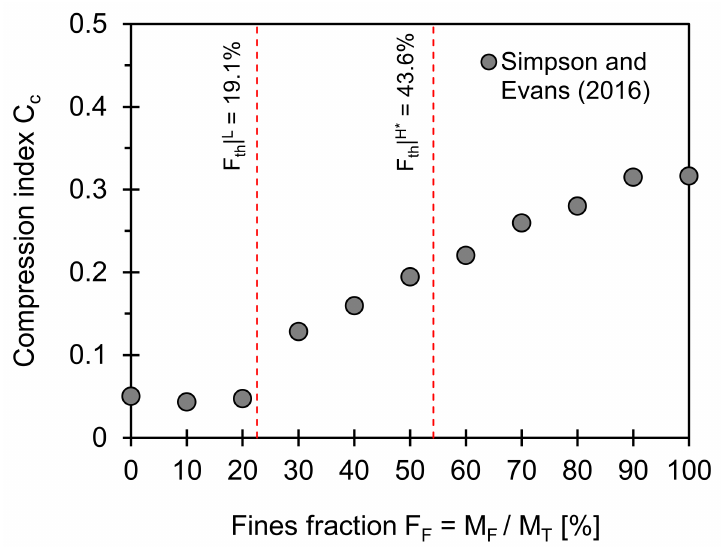
Figure 3. Compression index versus fines fraction. Two red dotted lines indicate low and data- adjusted high-threshold fines fractions computed using Equations (2) and (4). Input parameters used for estimation of two boundaries are e Cmax = 0.912, e Cmin = 0.584, e Fmax = 1.47; e Fmin = 0.53, and F th | L = 19.1%, and F th | H * = 43.6%. Note: Data extracted from Simpson and Evans